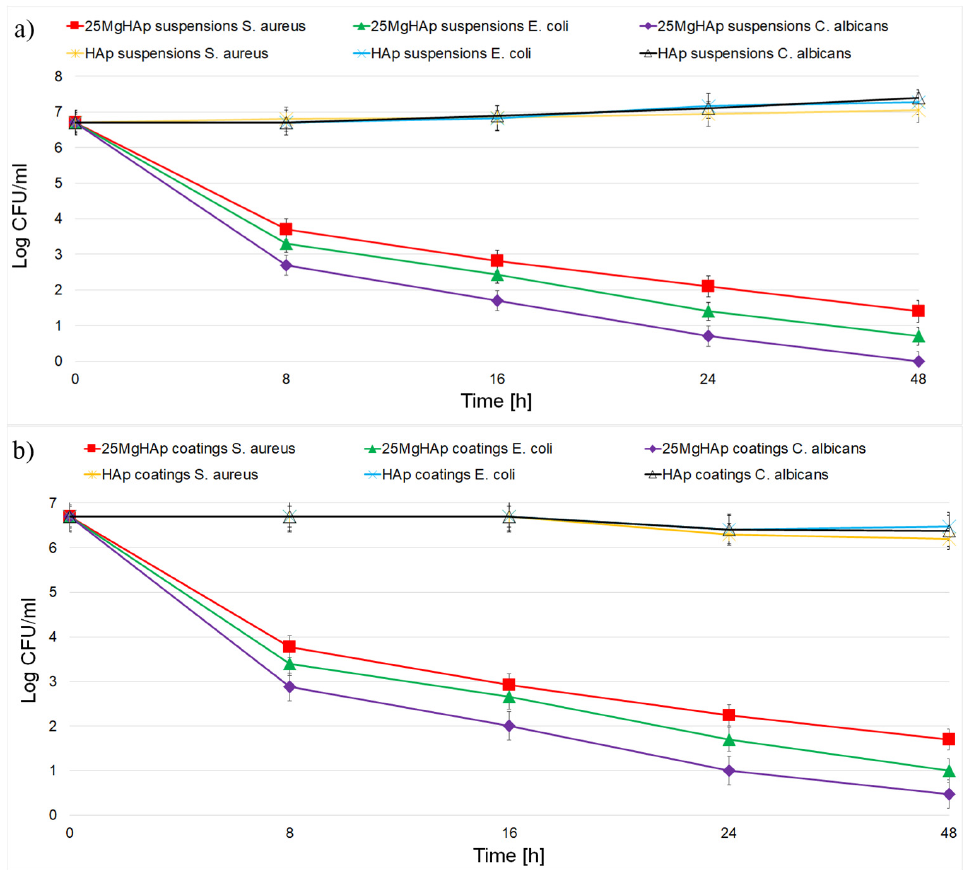
Figure 17. The graphical representation of the Log CFU/mL as a function of time of exposure to the 25MgHAp suspensions ( a ) and 25MgHAp thin films ( b ).